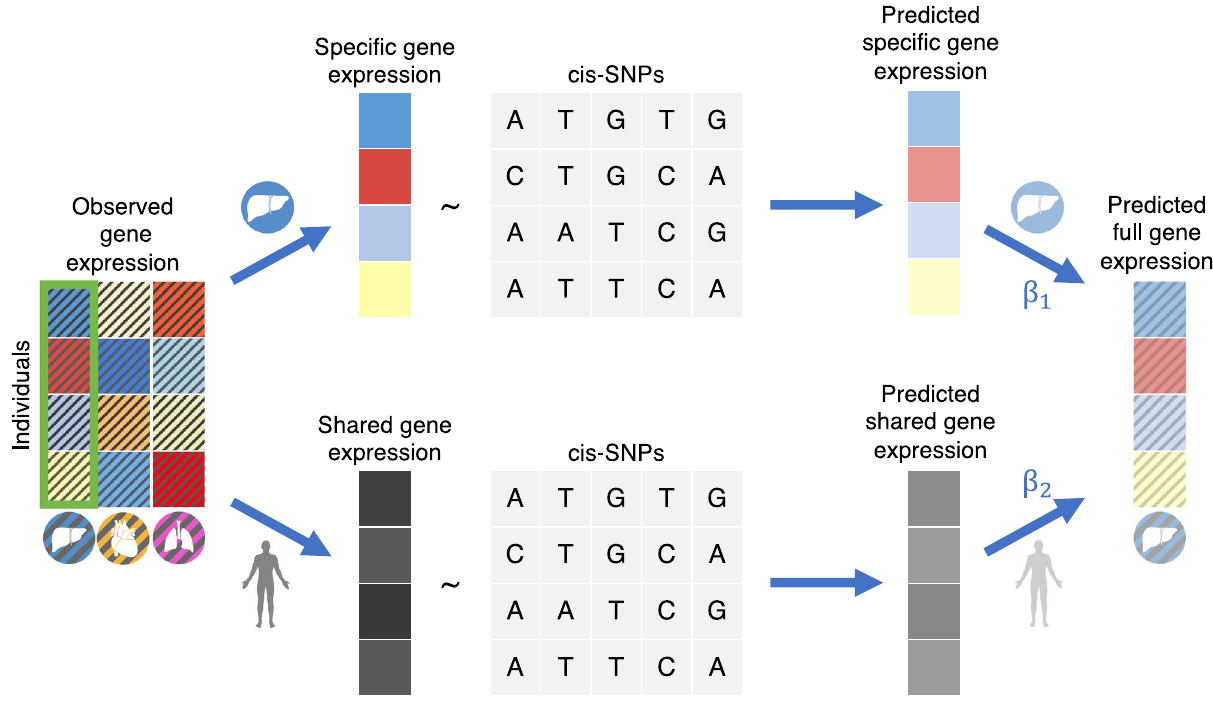
Fig. 1 | An overview of the CONTENT approach. CONTENT fi rst decomposes the observed expression for each individual into context-speci fi c and context-shared components following 16 . Then, CONTENT fi ts predictors for the context-shared componentofexpressionaswellaseachcontext-speci fi ccomponentofexpression